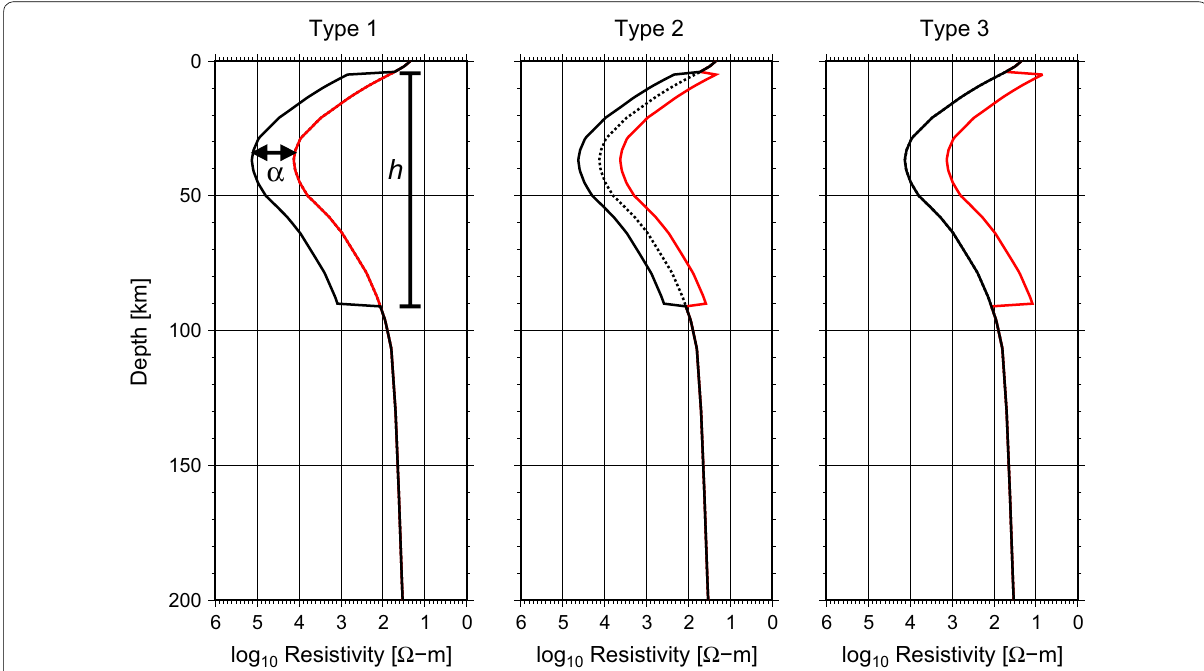
Fig. 1 Synthetic models with anisotropic lithosphere for three types for thickness of the anisotropic lithosphere h ropy α 1.0. Isotropic 1D model is the one shown in Sarafian et al. (2015). The bottom of the anisotropic lithosphere is fixed to be 90 km depth. = For the anisotropic lithosphere, the red line shows a most conductive direction that is supposed to be parallel to the fossil spreading direction ( y -direction), and the black line shows a least conducive direction that is supposed to be perpendicular to a fossil spreading direction ( x -direction). The isotropic 1D model is consistent with the red line for type 1, the dotted line for type 2, and the black line for type 3, respectively, in the aniso- tropic